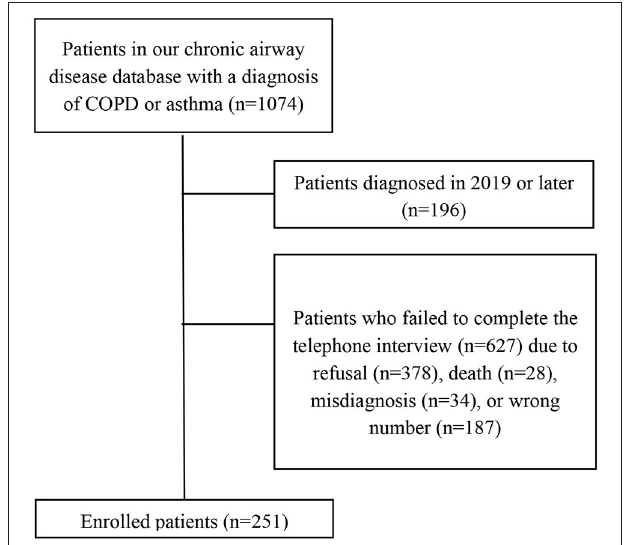
FIGURE 1 | Flow chart of the follow-up process. Refusal refers to refusal to call or interview or no answer to call.